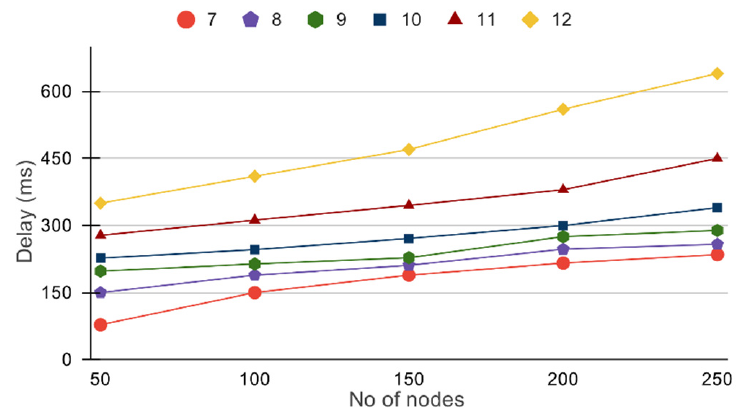
Figure 14. Number of nodes versus end–end delay.